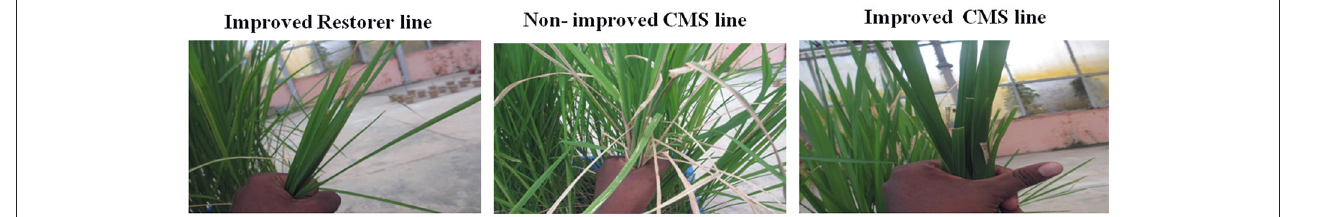
FIGURE 4 | Differential reactions of Xoo isolates on rice leaves at 14 dpi upon artificial clip inoculation.